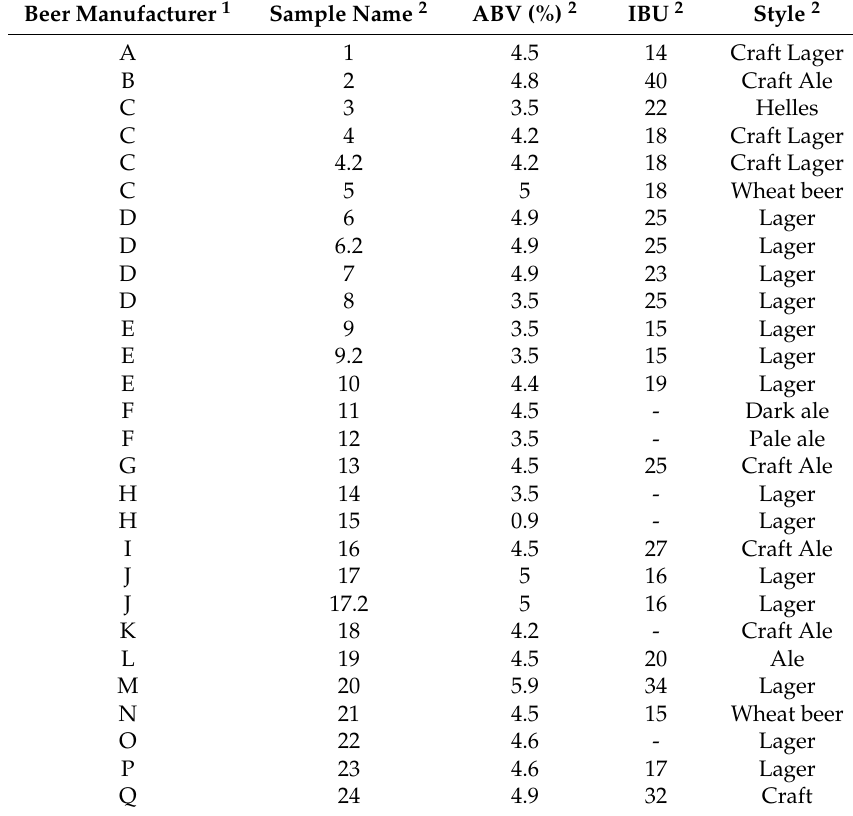
Table 1. List of the beer samples analyzed in this